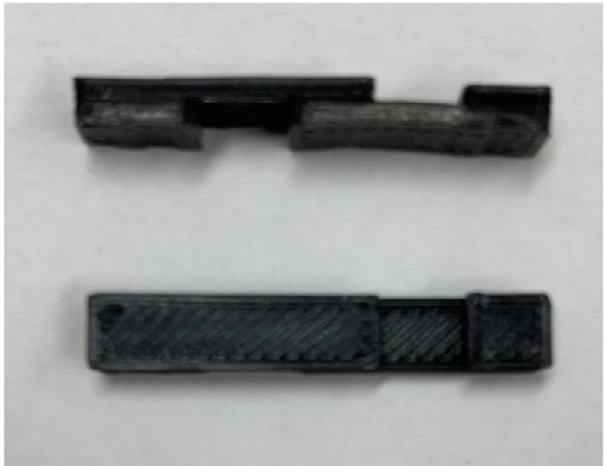
Figure 15. Shear specimens printed using PLA + 2% graphite.